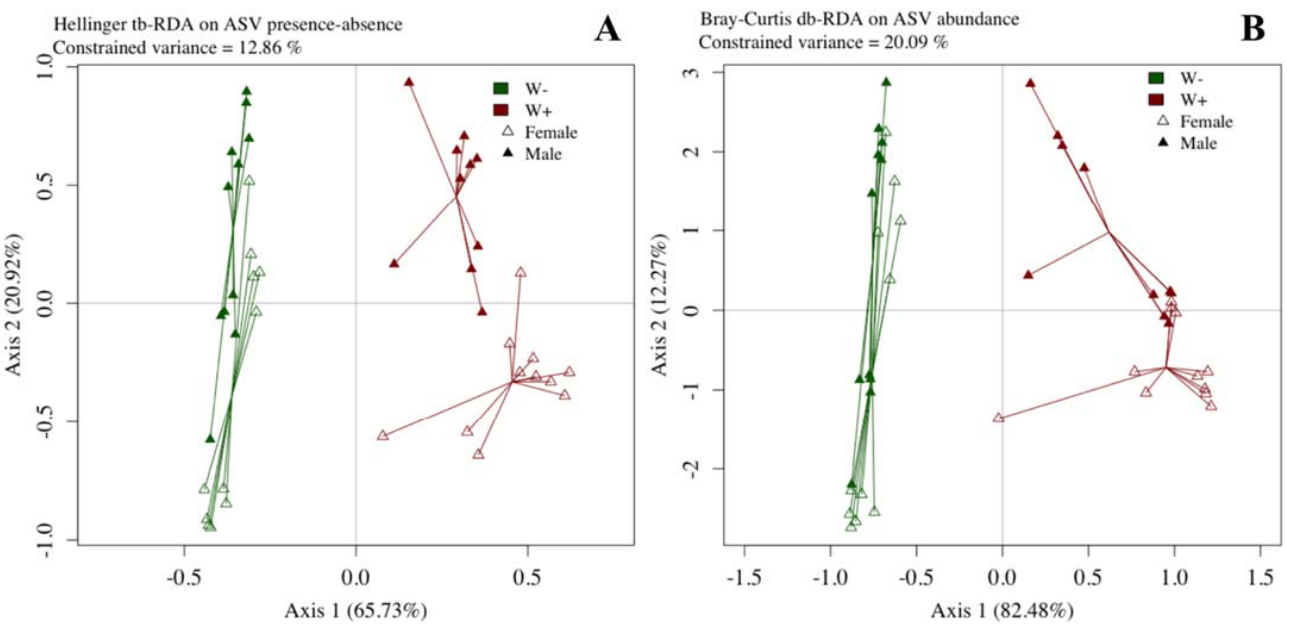
Figure 2. Bacterial community structure of the Wolbachia -free (“W − ” in green) and infected (“W+” in red) lines.